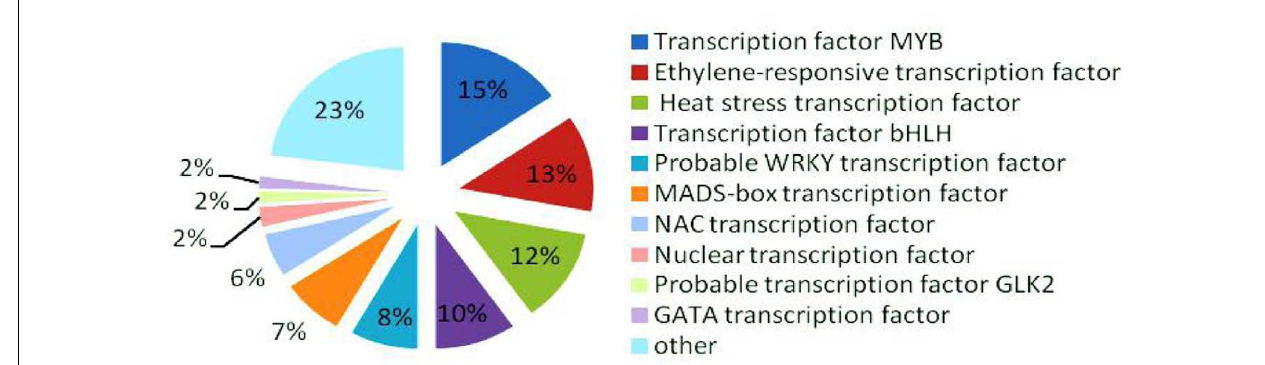
FIGURE 7 | Relative proportions of different transcription factors detected.